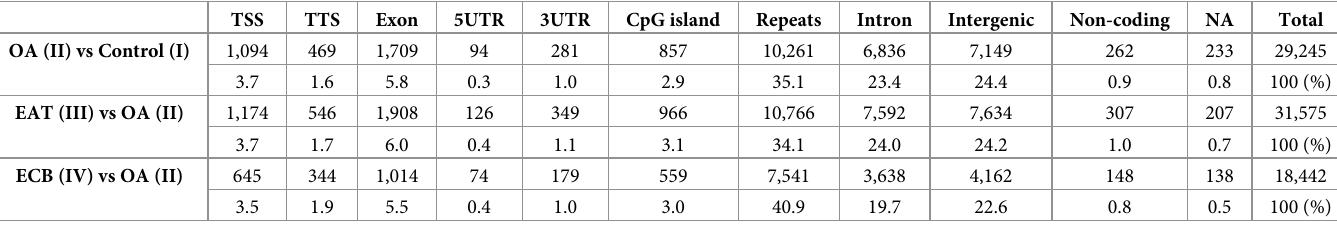
TSS (transcription start site), TTS (transcription termination site), Repeats (SINE, LINE, Alu, Simple repeats, LTR), NA (not